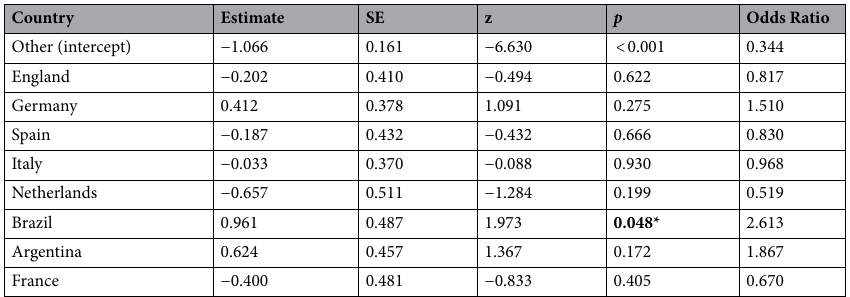
Table 1. Coefficients for the different nationalities in the binomial regression model for all kicks taken in penalty shootouts faced by goalkeepers during World Cup and European Championship matches (123 of 473 penalty kicks were missed against 71 different goalkeepers in the analyzed time periods). The p values marked bold represent significant results ( p <